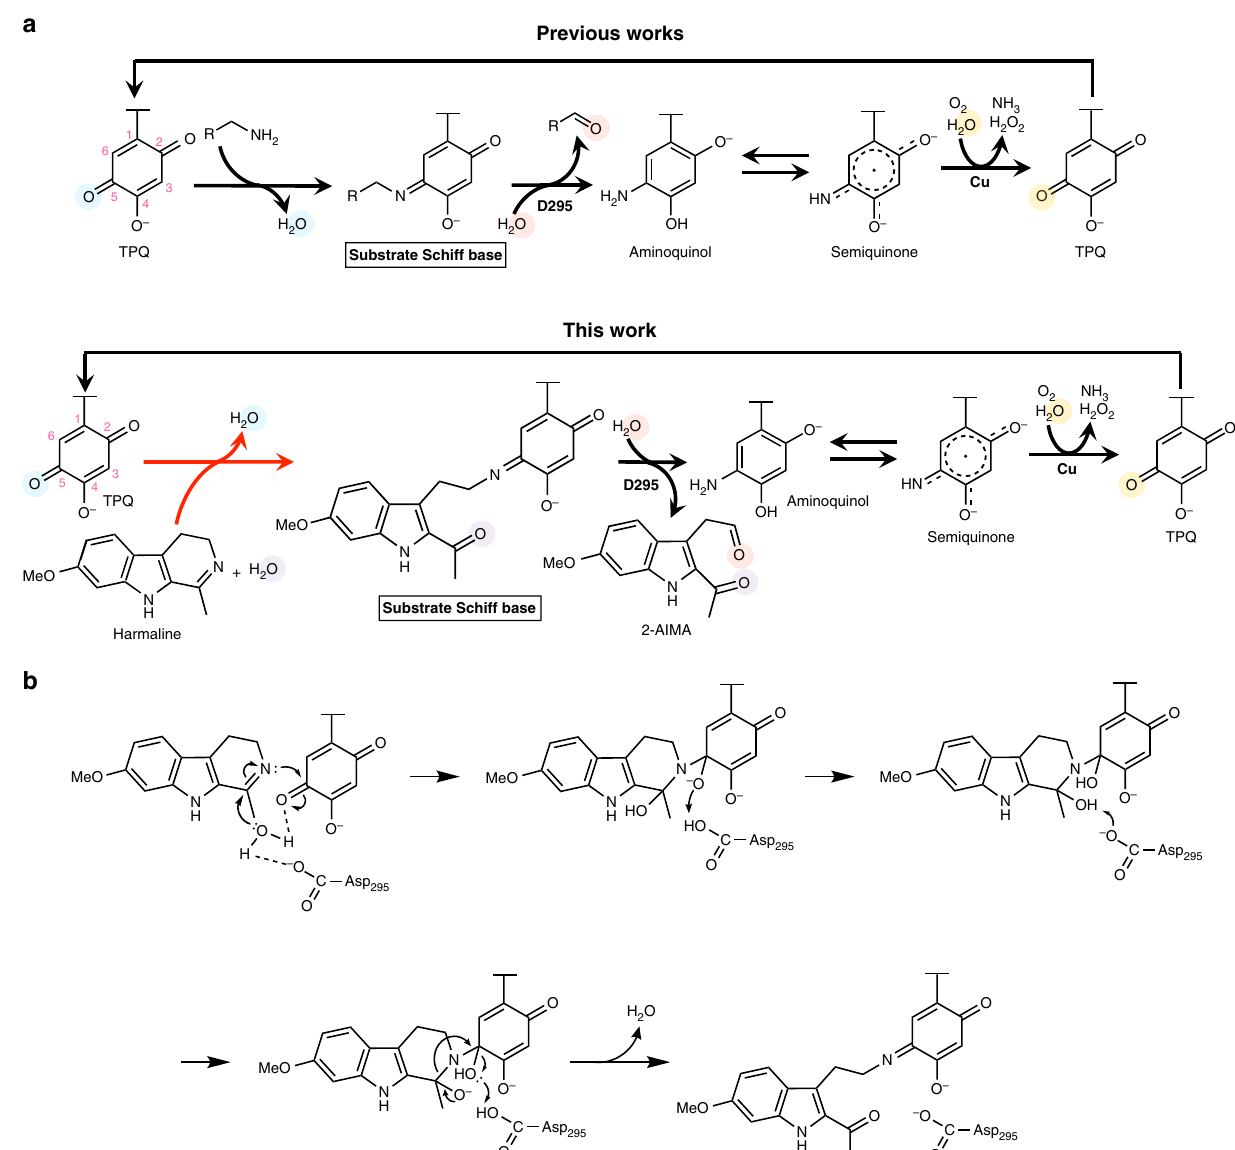
Fig. 7 Schematic diagram of a possible reaction mechanism of HarA-catalyzed reactions. A possible reaction mechanism of two-step degradation of harmaline by HarA. a The reaction mechanisms of oxidation of an amine substrate (top) and degradation of harmaline (bottom) catalyzed by CAO. The reaction found in this study is indicated by a red arrow. Each substrate forms substrate Schiff base with TPQ. Substrate Schiff base is converted to product Schiff base (not shown in the fi gure) through deprotonation by deprotonated Asp295. Hydrolysis of product Schiff base is facilitated by protonation of the intermediate by protonated Asp295. b A possible reaction mechanism of the hydrolysis of cyclic imine and the formation of substrate Schiff base (indicated by the red arrow in a ) when harmaline was used as the